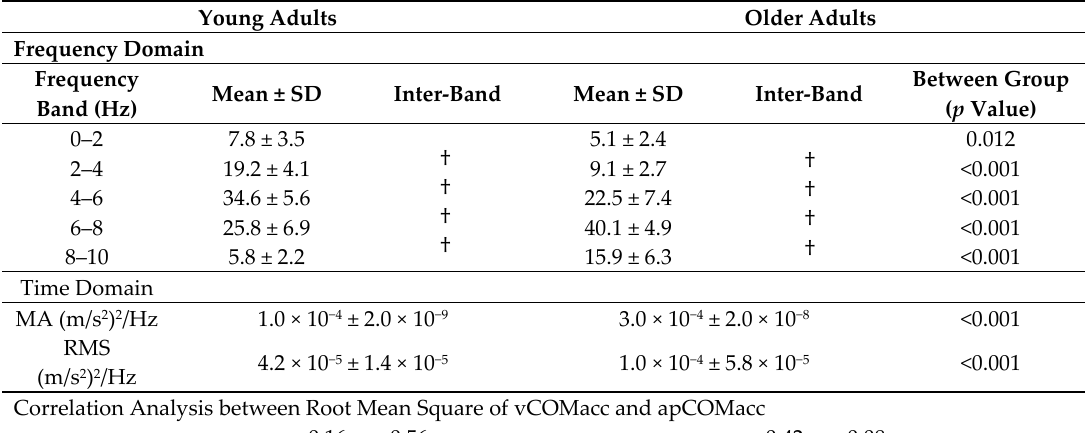
Values presented are means and standard deviations of the normalized power spectral density of each frequency band. Comparison of each frequency band, MA, and RMS di ff erences between both groups. † , Statistical analysis within each frequency band. The last row of the table shows the correlation results between the root mean square of vCOMacc and apCOMacc. MA: maximum amplitude, RMS: root mean